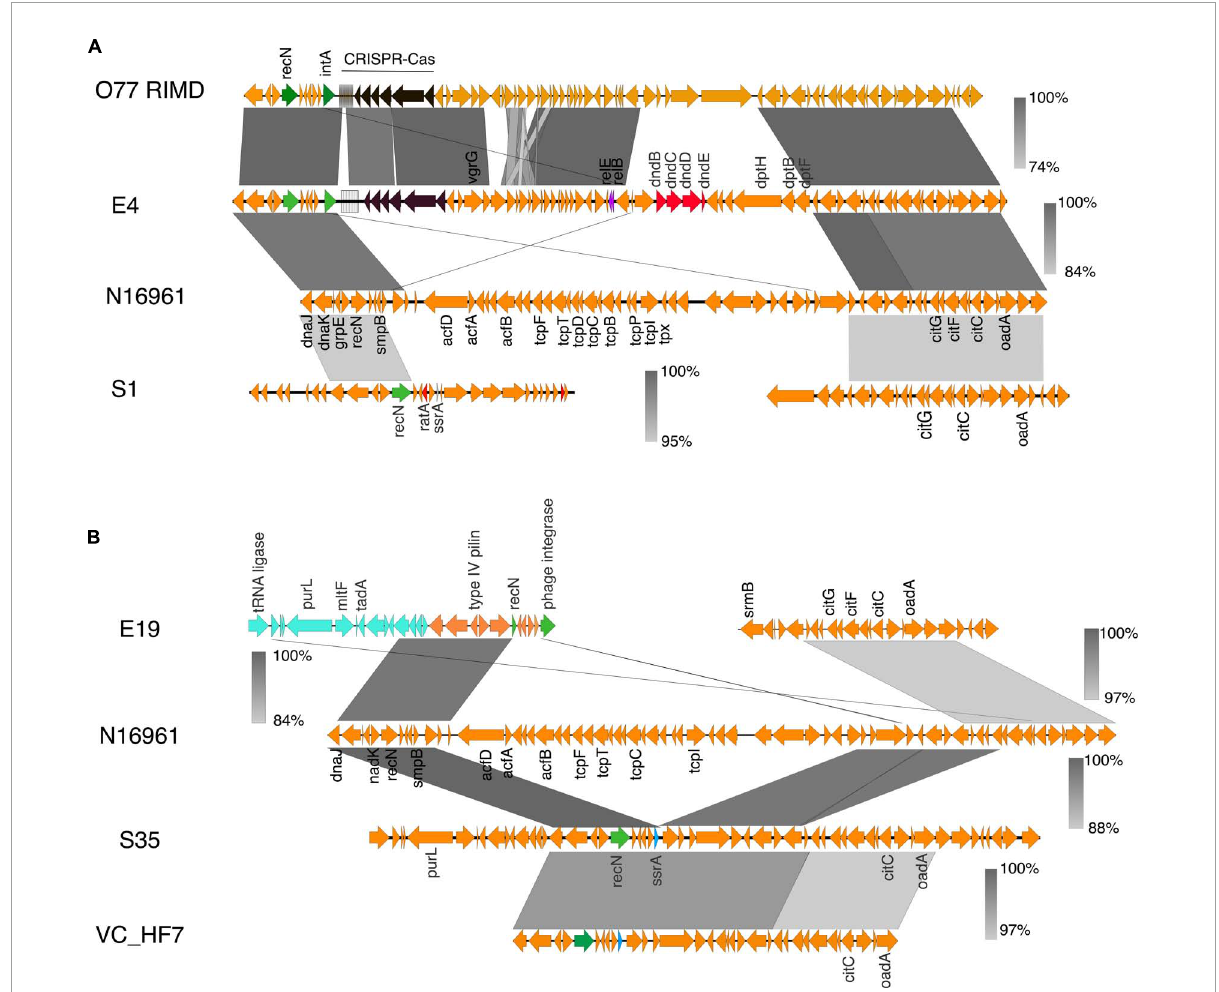
FIGURE3 Virulence genes in V. cholerae isolates. (A) The gene organization and alignment of the acf and tcp region in the N16961, O77 RIMD and the environmental isolates S1 and E4. (B) Genetic organization of the tcp and acf gene cluster region in N16961, VC-hf7 and the isolates E19 and S35. The grayscale bars show the nucleotide homology in the aligned regions. Insertion elements, DNA metabolism genes, the phage sequences are in